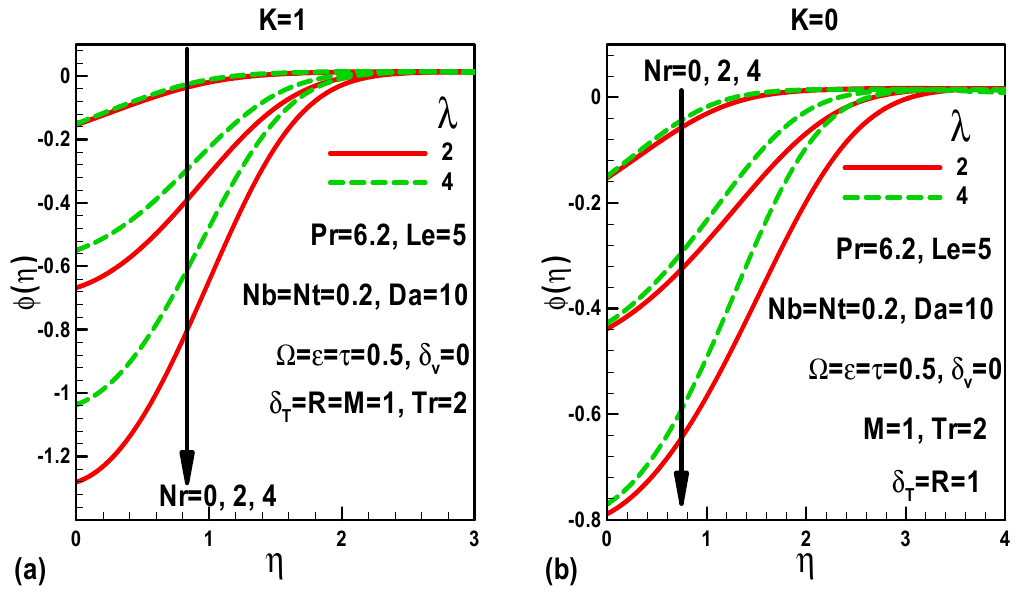
Figure 8. E ff ects of buoyancy ratio and mixed convection parameters on dimensionless concentration ( a ) with pressure gradient and ( b ) without pressure